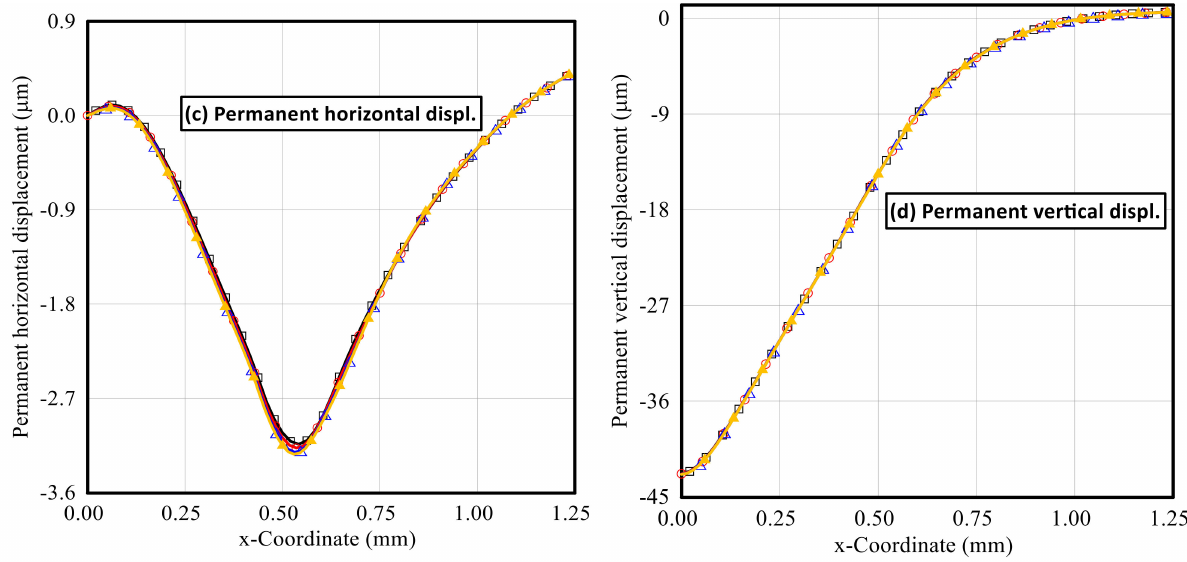
Figure 6. Influence of the FE mesh size on displacement profiles along the upper surface of an elastoplastic P-FGM Ti/TiB specimen at k = 0.5; ( a ) horizontal, ( b ) vertical, ( c ) permanent horizontal, and ( d ) permanent vertical